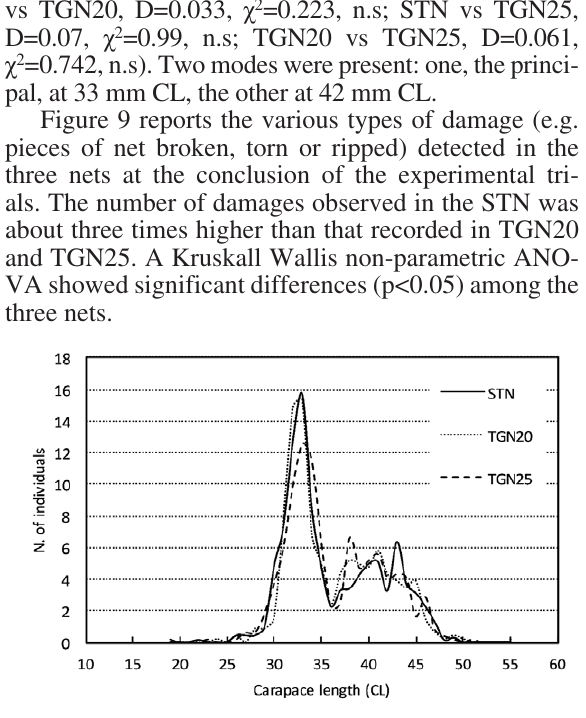
Fig. 8. – Length frequency distribution of the specimens of P. kera- thurus caught with the three types of net.